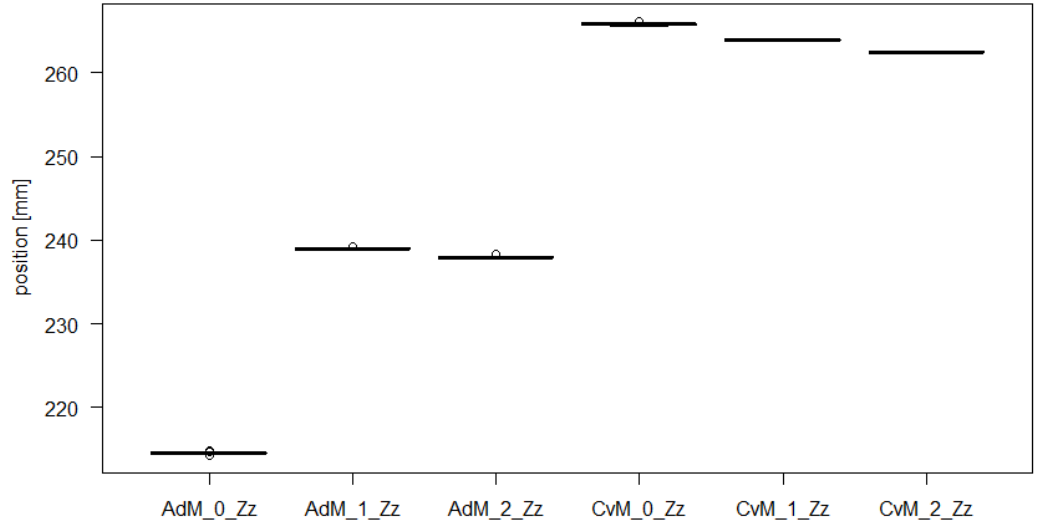
Figure 15. Measurements of CoM axis